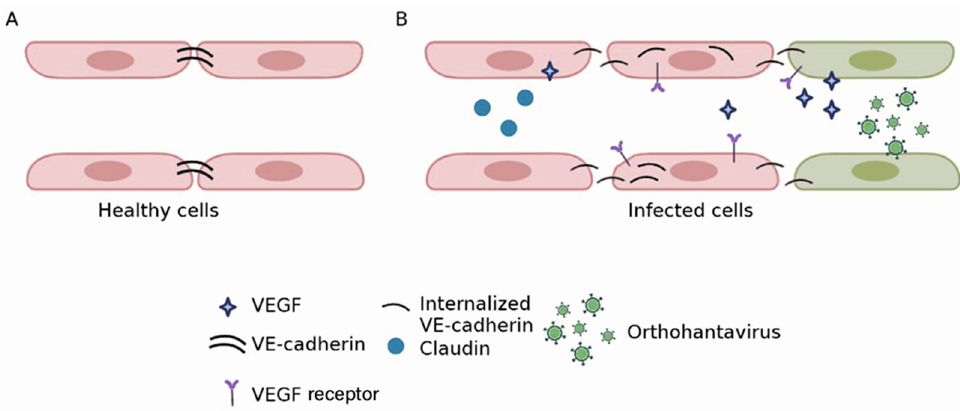
Figure 3. Orthohantavirus effect on endothelium barrier integrity. In uninfected endothelial cells, VE-cadherin is expressed in junctions between adjacent cells ( A ). In orthohantavirus-infected cells, a profound reorganization of VE-cadherin was described ( B ). It was shown that VE-cadherin becomes internalized in orthohantavirus-infected endothelial cells. This change in molecule expression appears to be a response to the binding of infected cells to VEGF. As a result, the integrity of adherence junctions becomes compromised, leading to increased endothelium permeability. Expression of claudin, a TJ molecule, decreased in orthohantavirus-infected cells. This would also contribute to the disintegration of cell adhesion and vascular